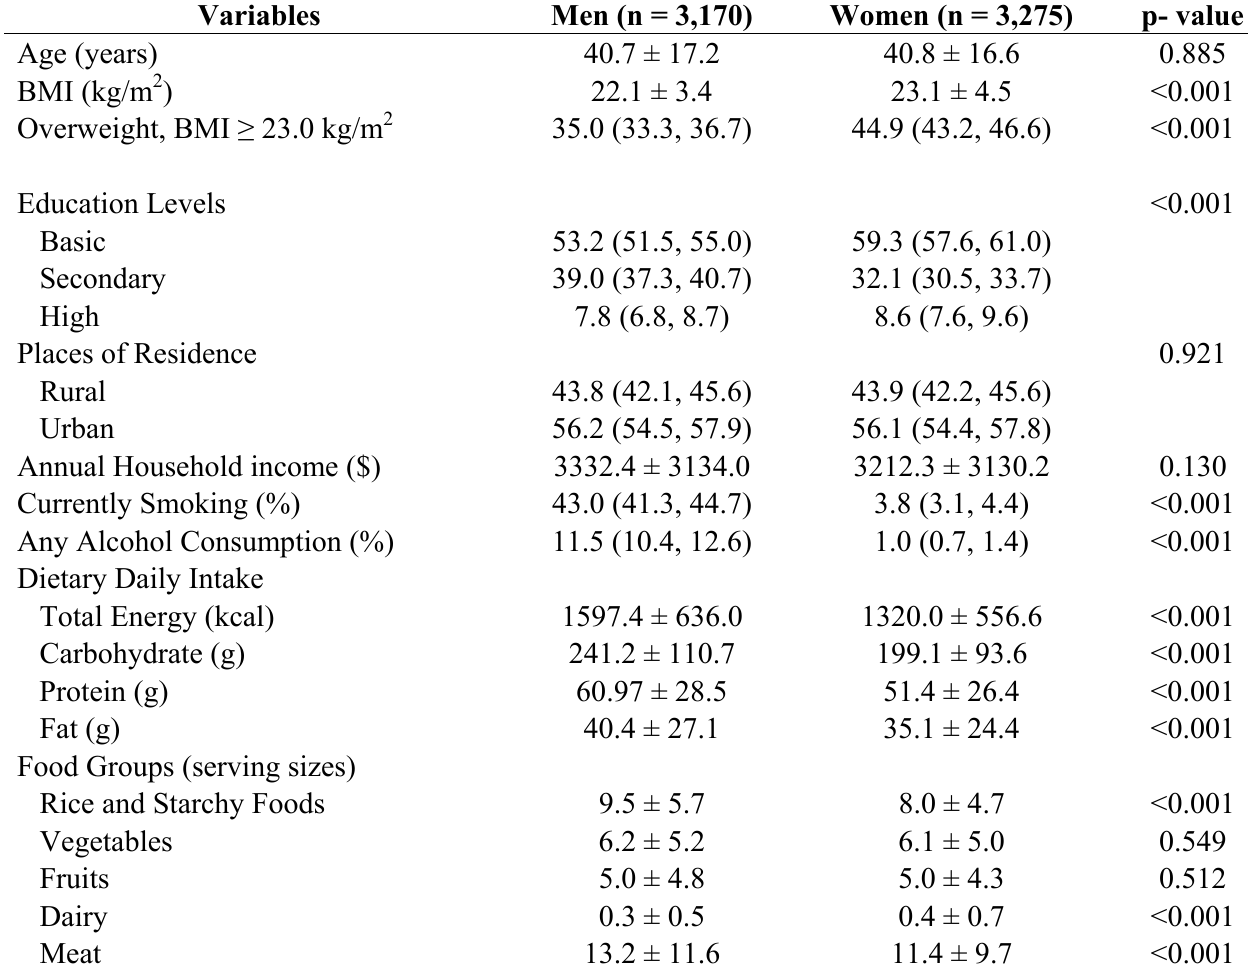
Table 1. Characteristics of a representative sample of Thai adults by gender a